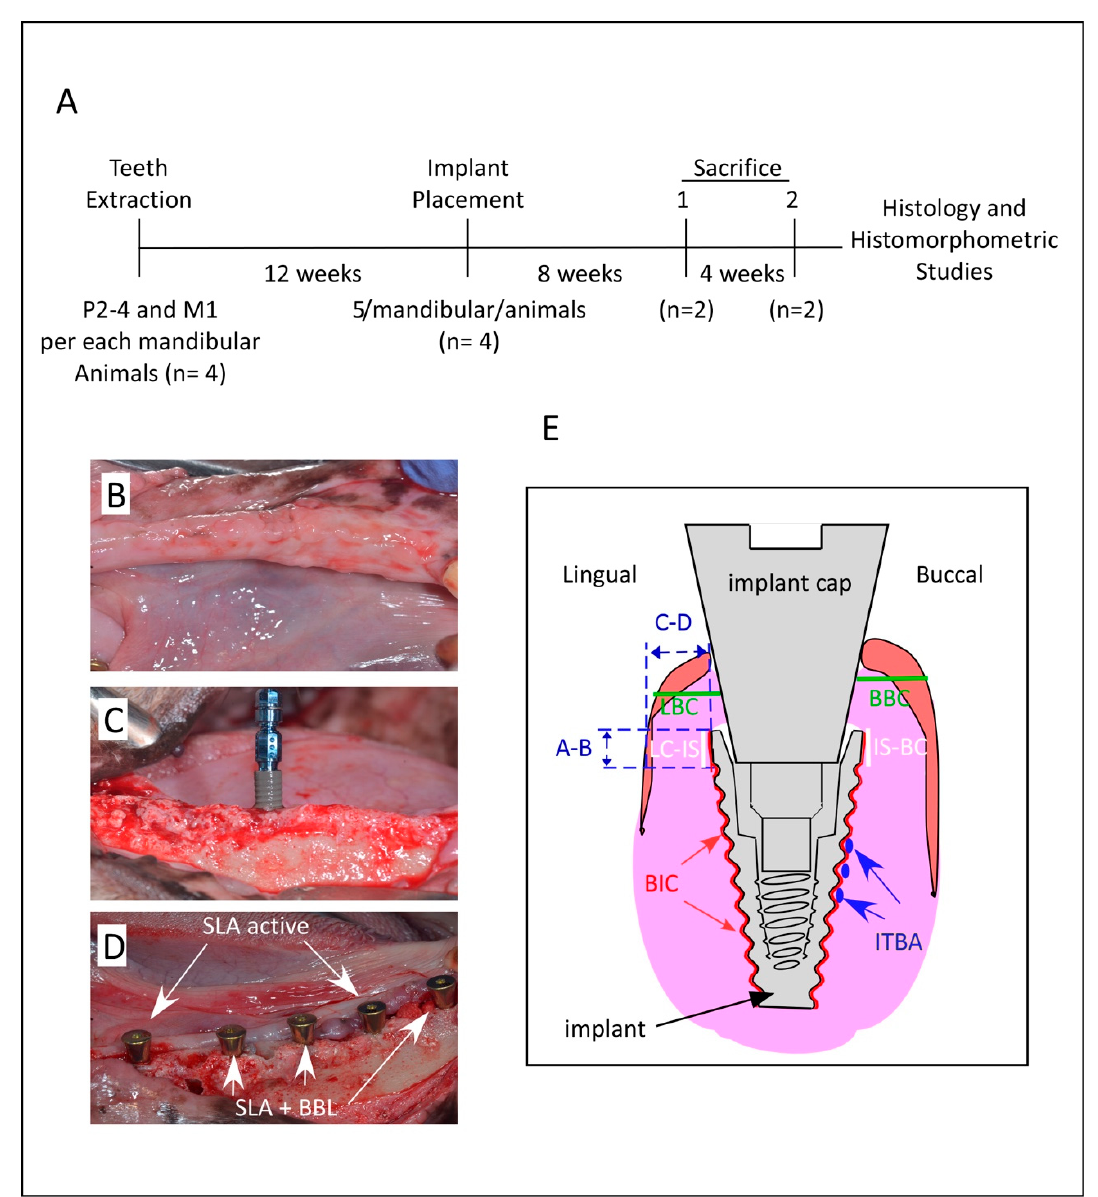
Figure 1. Experimental Procedure . ( A ). Timeline of the current study. Representative images for ( B ) healed bone after 12 weeks post extraction; ( C ) Straumann BLT-SLA implant with BBL liquid; and ( D ) five implants with healing abutments in place with the distribution of BLT-SLA implants with BBL pre-treatment (test group) and BLT-SLA active (control group). ( E ). Illustration of histomorphometric parameter measurements. Total bone-to-implant contact (BIC) was measured around the total endosseous circumference of the implant as the percentage the implant surface in contact with bone over the total implant surface (red line). Inter-thread bone area percentage (ITBA) is illustrated in the yellow insert. Buccal (BBC) and lingual (LBC) bone crest measurements from the implant shoulder (IS) to BIC contact to BBC (IS-BC) and LBC (LC-IS), respectively. Crestal bone loss measurements vertically, the distance between the implant collar and the first crestal bone contact = A-B is bone height. Tissue thickness measurements horizontally, the distance between the implant collar to the external portion of the tissues = C-D is tissue thickness.